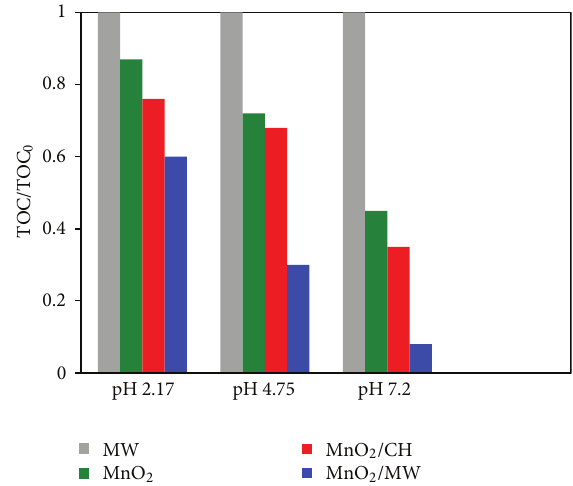
F 7: Ratio of remaining TOC at 10min to original TOC ) for dye solution. [MB] = 10mg/L, [MnO (TOC time 10min, and solution pH 0